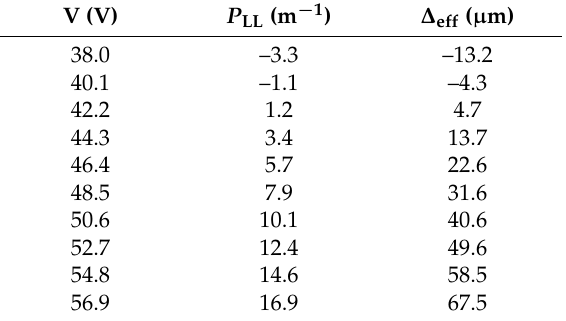
Table 1. Optical power in the LL and effective displacement of the ORP induced while changing the voltage.